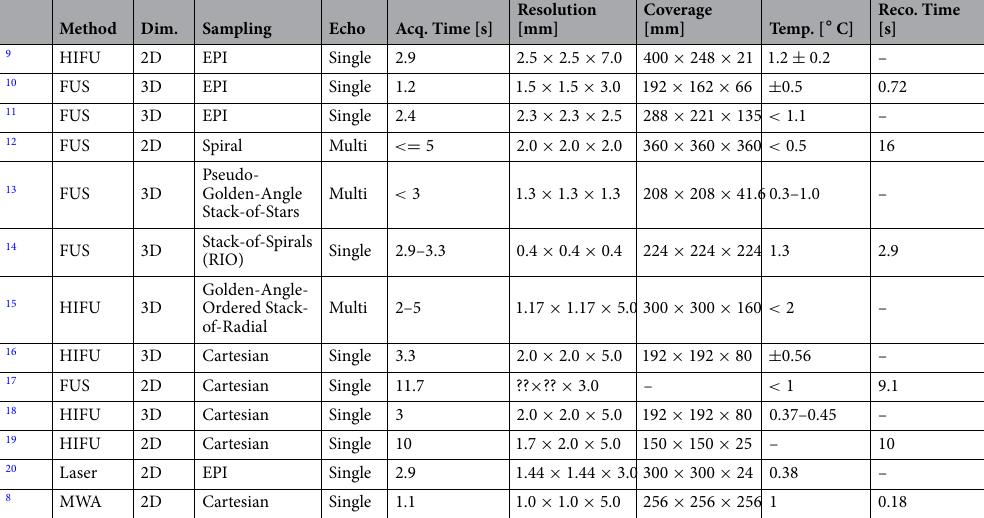
Table 1. Overview of the related work on different approaches to create a volumetric heat map. The table is sorted with respect to the year of publication starting from 2009 to 2021 in ascending order.